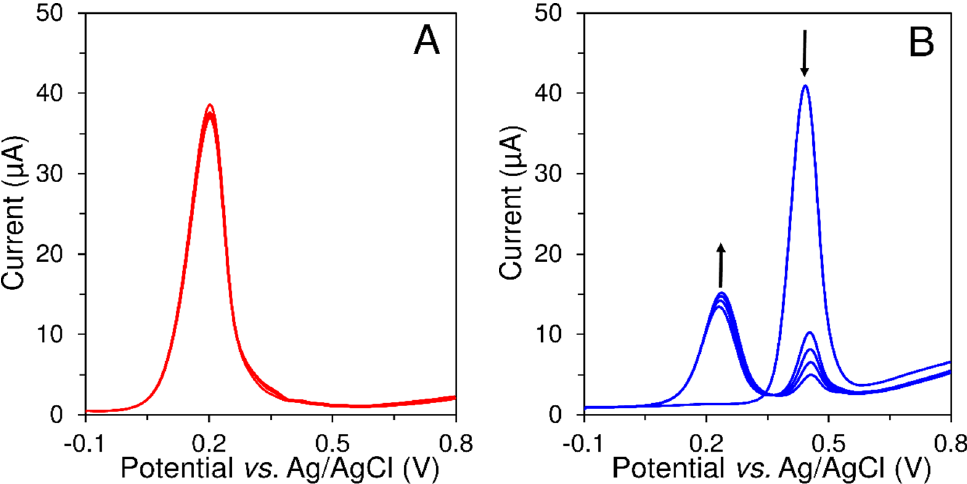
Figure 3. Repetitive SWV of VK1 (red, A ) and α -TOH (blue records, B ) adsorbed onto GCE surface from their 50- µ mol L − 1 solution (accumulated from 50% MeCN at stirring speed of 400 rpm for 5 min) in 0.01-mol L − 1 HNO 3 containing 0.1-mol L − 1 KCl (pH 2.08) at E dep = − 0.1 V, t dep = 60 s, t eq = 5 s, E step = 5 mV, E ampl = 30 mV and f = 80 Hz.